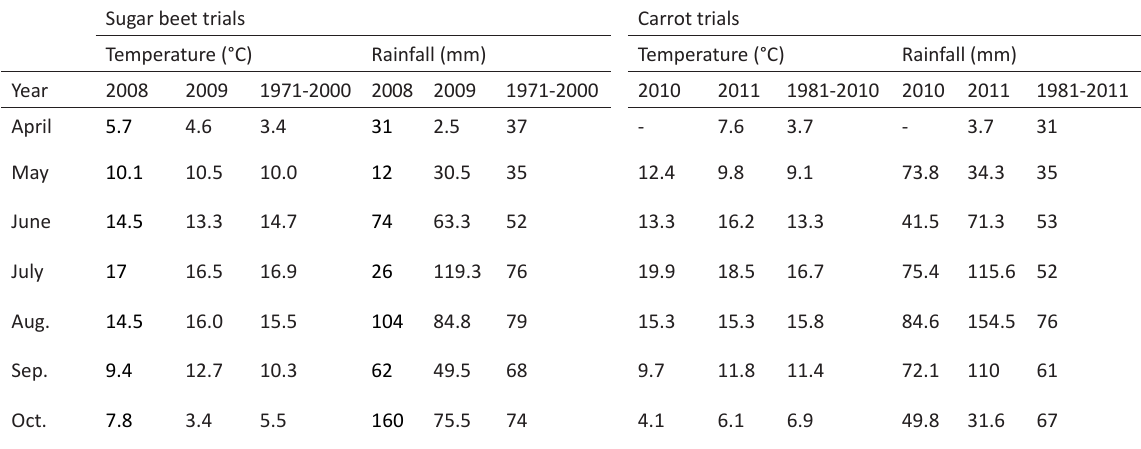
Table 3. Temperature and rainfall in the growing seasons of the field trials (Finnish Meteorological Institute weather station data from Kaarina 60 o 39’N 22 o 55’E for sugar beet, and Kauhajoki 62 o 41’N 22 o 18’E for carrot) Sugar beet trials Carrot